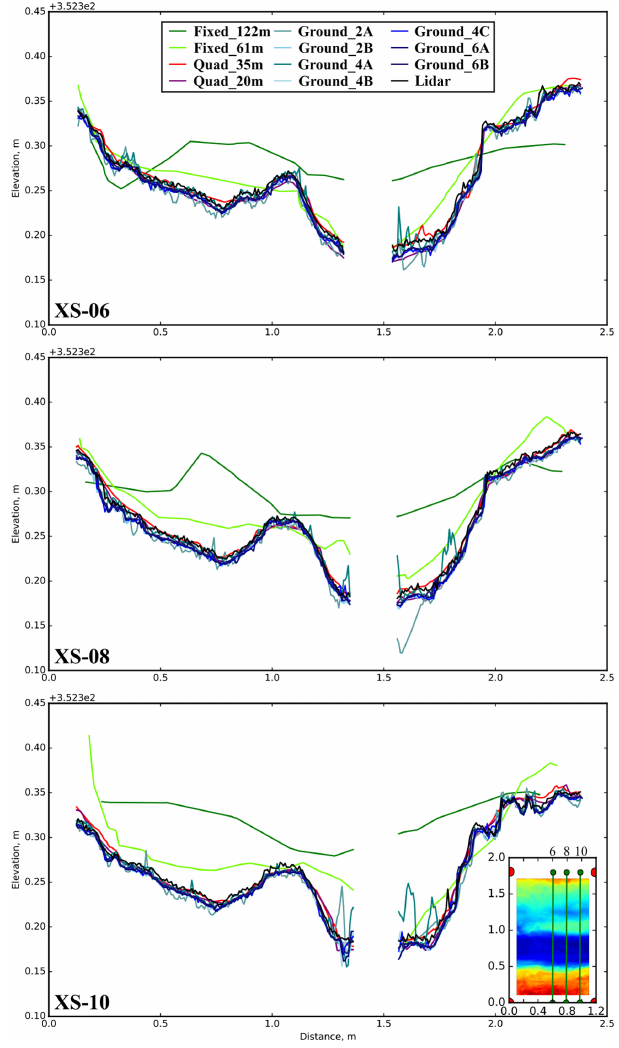
Figure 12. Selected cross sections generated from interpolating point clouds into a 5 × 5mm raster grid file.